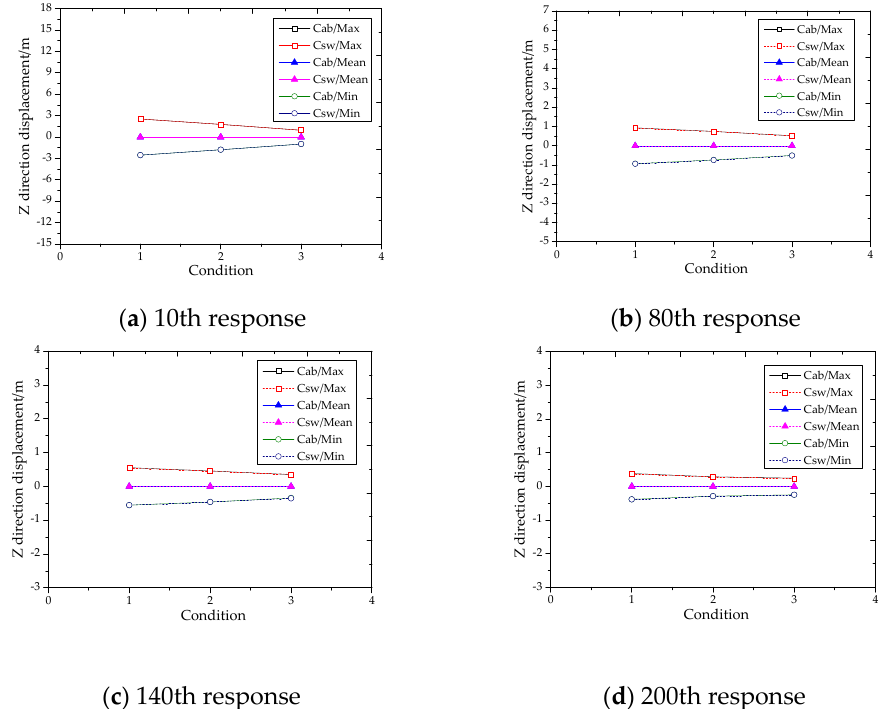
Figure 13. 10th – 200th z -direction response changing with conditions Figure 13. 10th–200th z -direction response changing with conditions. Table 9. Reduction, difference and normalized values of node’s maximum Table 9. Reduction, difference and normalized values of node’s maximum response.